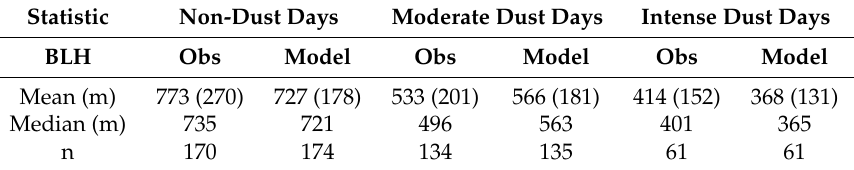
Table 2. Same as Table 1 but for the summer season